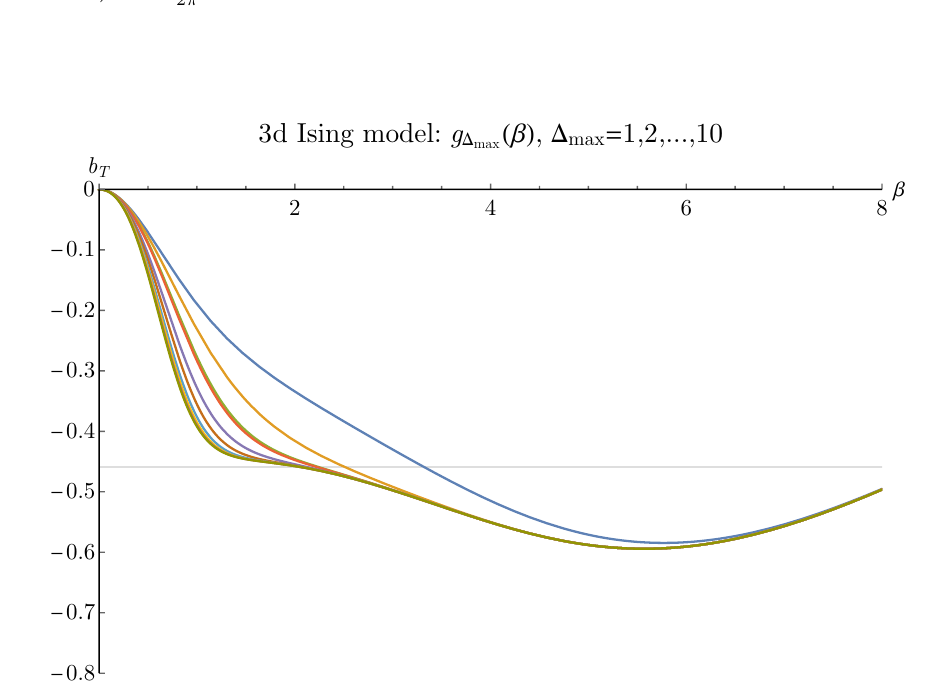
Figure 13. The function g (cid:1) ( (cid:12) ) in the 3d Ising model, estimated using known operators only, max and plotted for the values (cid:1) max = 1 ; 2 ; : : : ; 10. The value of b T determined from Monte Carlo simulations is (cid:0) 0 : 459 (gray horizontal line,